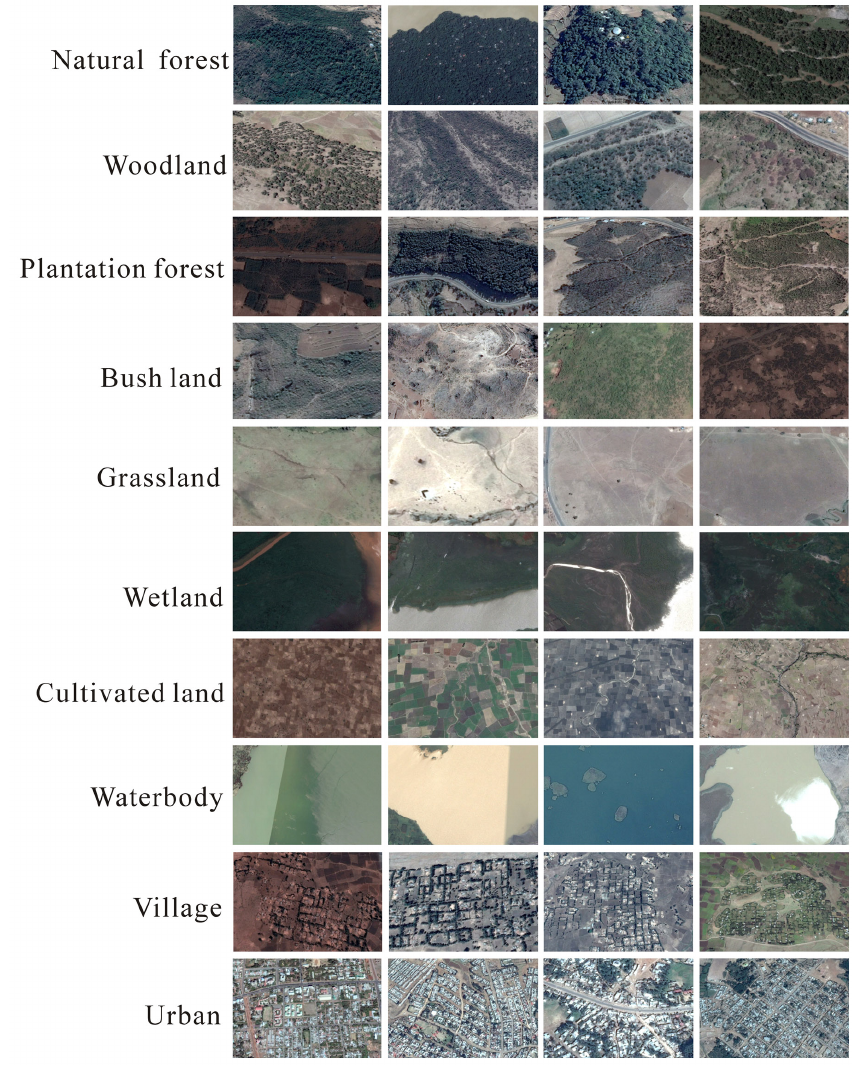
Figure 2. Interpretation marks based on the Google Earth